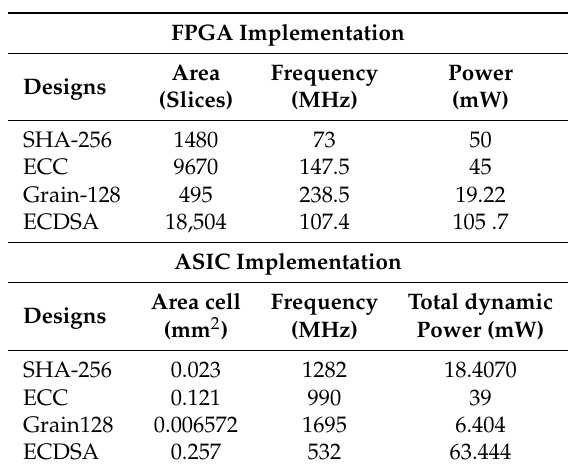
Table 8. ECDSA Crypto-processor implementation results.